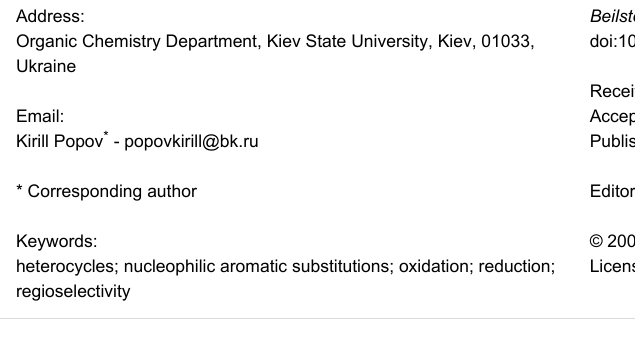
hydes 1 and nitriles 2 should provide new benzo[ e ][2,1]thiazine derivatives, which can be used as intermediates for the synthesis of more elaborate compounds with potential biological